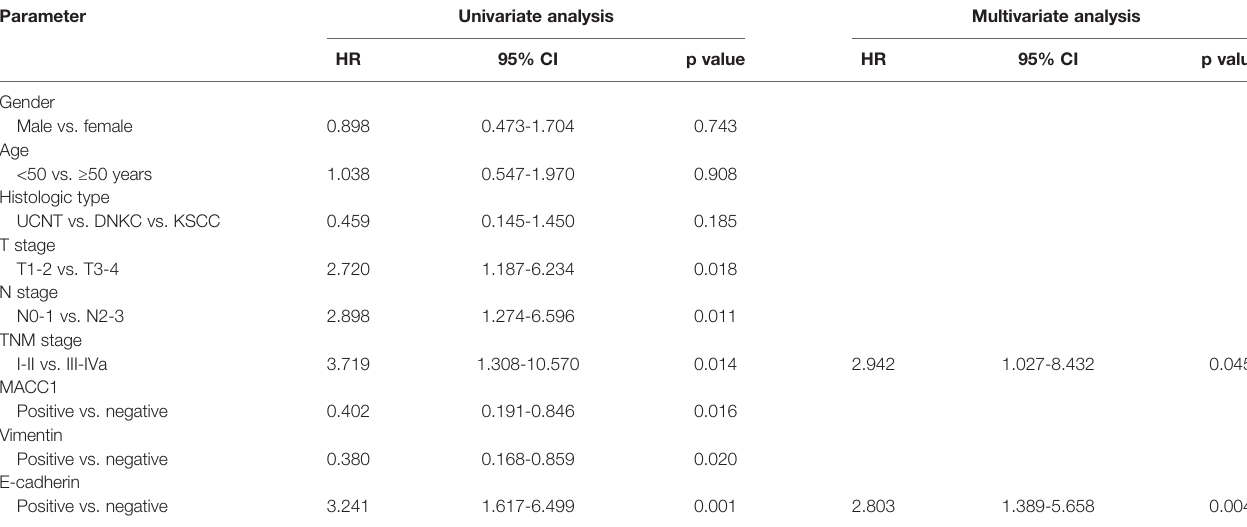
TABLE 4 | Univariate and multivariate analyses of prognostic factors for 5-year metastasis-free survival of NPC